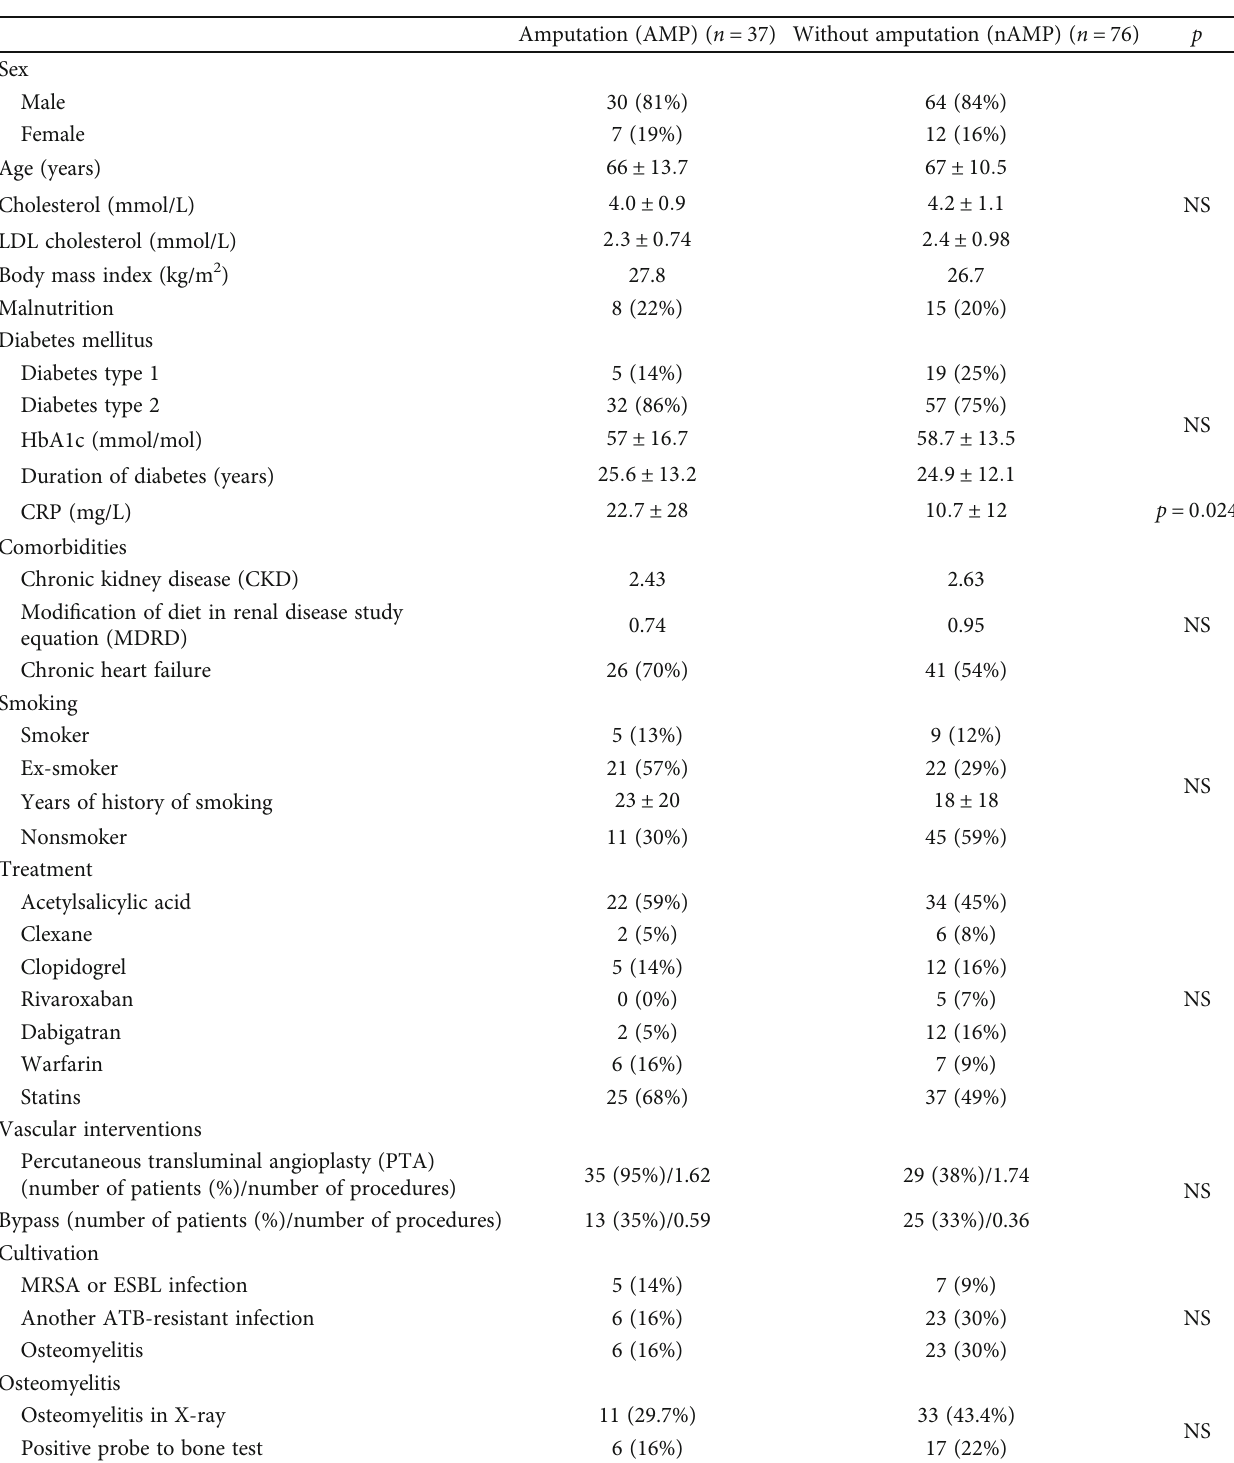
Table 1: Baseline characteristics of